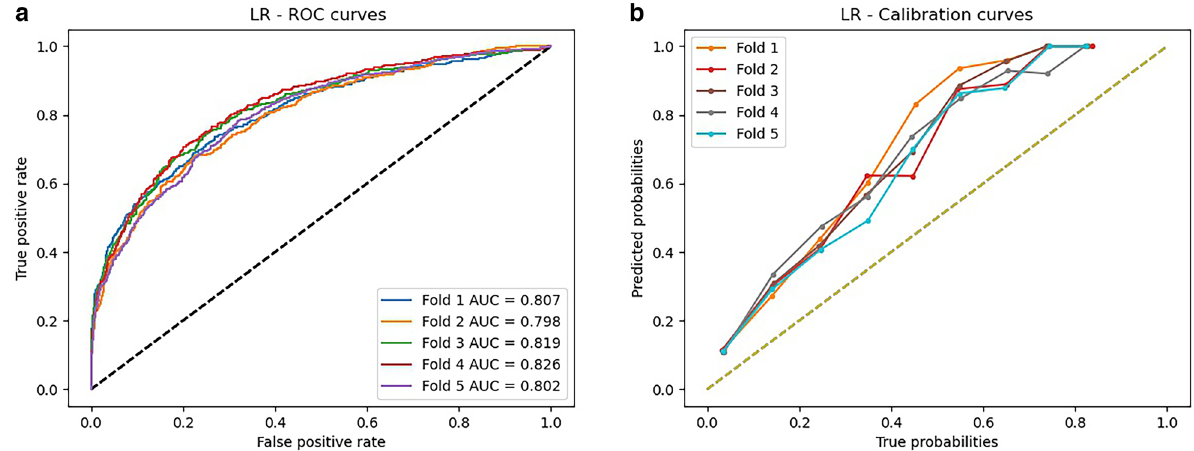
Figure 2. Logistic regression ( a ) receiver operating characteristic curve and ( b ) calibration curves for five outer validation folds. AUC—area under the curve.